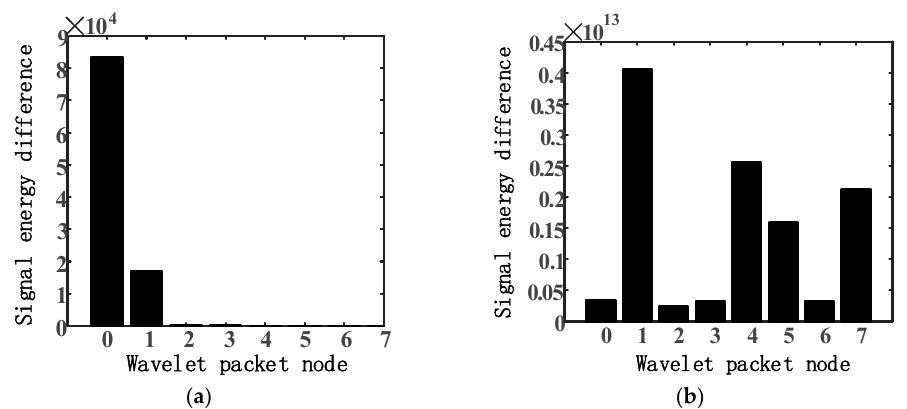
Figure 7. Wavelet packet node energy difference diagrams of the normal motor and the stator inter-